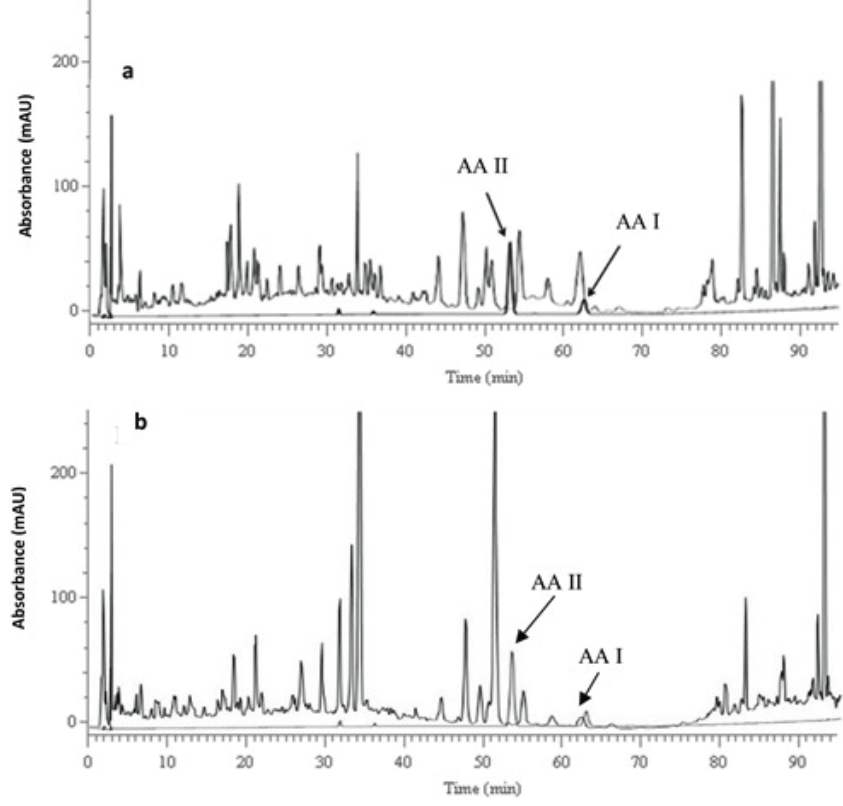
Figure 3 - HPlC chromatograms, at 254 nm, of crude ethanolic extract (Cee) from stems (a) and leaves (b) of Aristolochia triangularis with reference standards: aristolochic acid I